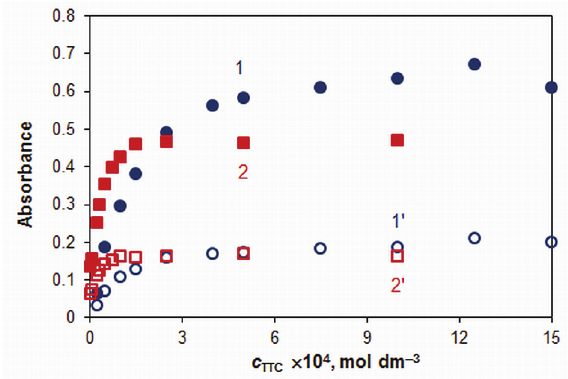
Figure 3. Absorbance of extracted complexes vs concentration of TTC. pH 5.5, c = c = 3×10 −5 mol dm −3 , c = 4.0×10 −4 mol dm −3 , V(IV) V(V) ND λ = 333 nm (1 and 2) or 630 nm (1’ and 2’). 1 and 1’ obtained with V IV , and 2 and 2’ – with V V